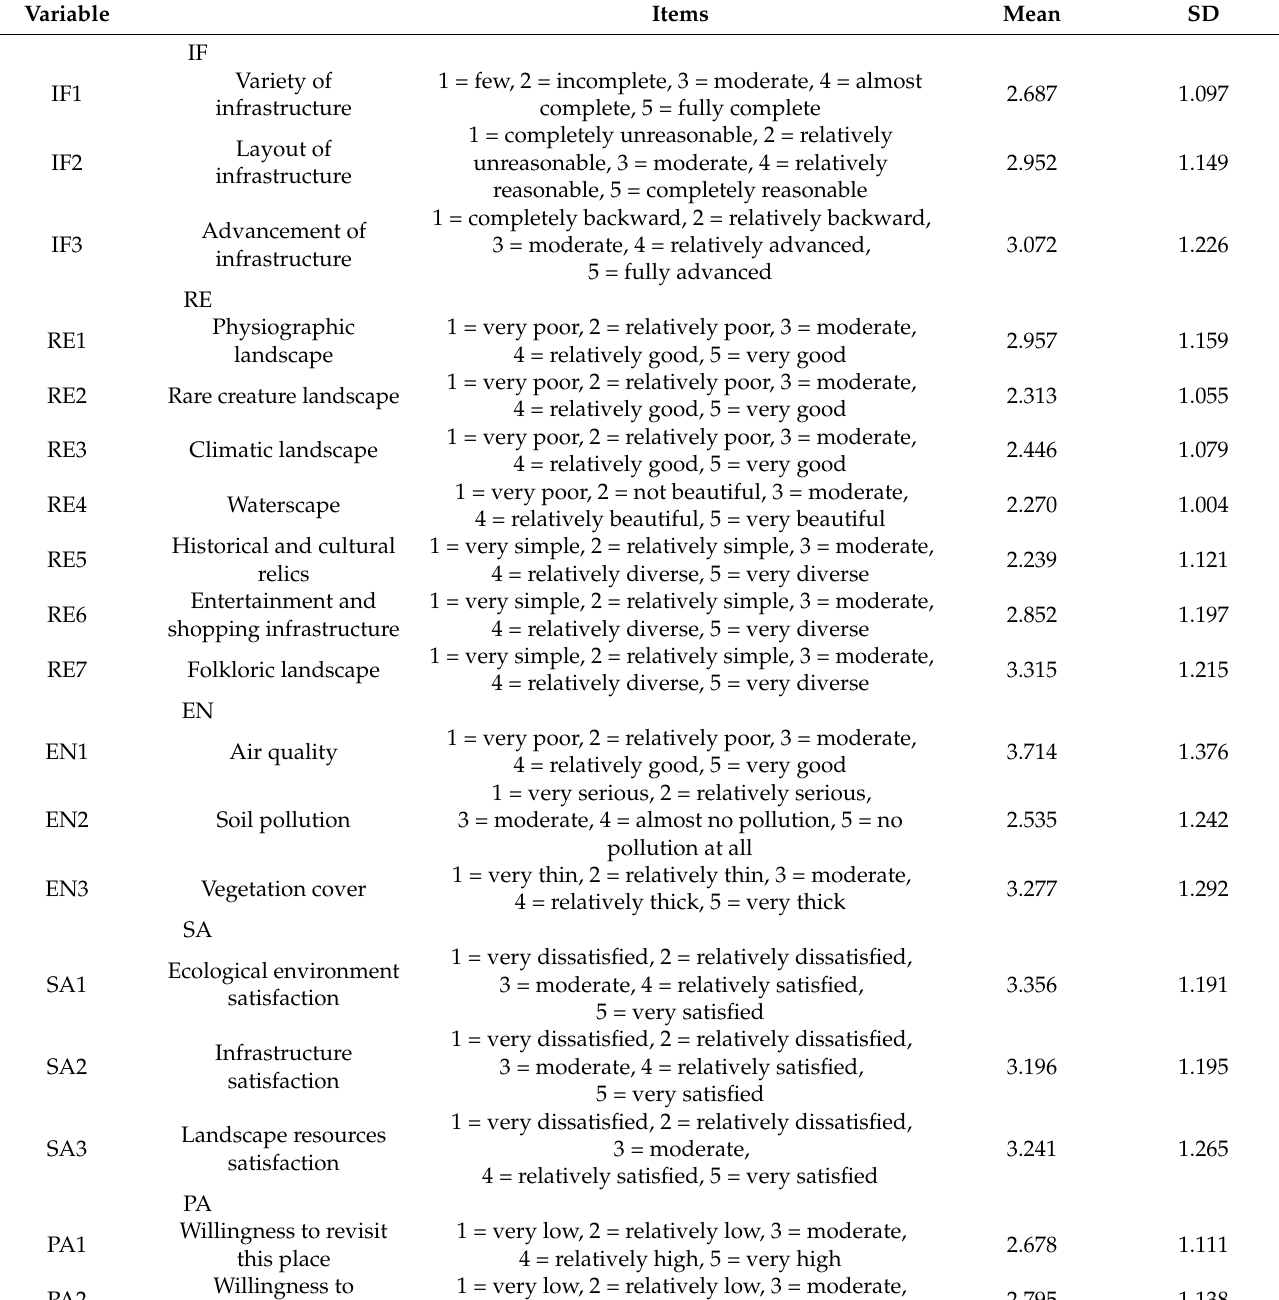
Table 3. Values and characteristics of